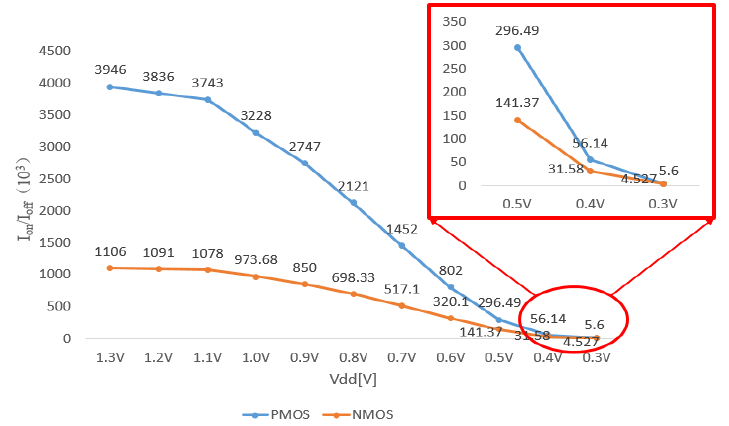
Figure 1. Device turn-on to turn-off current ratio.